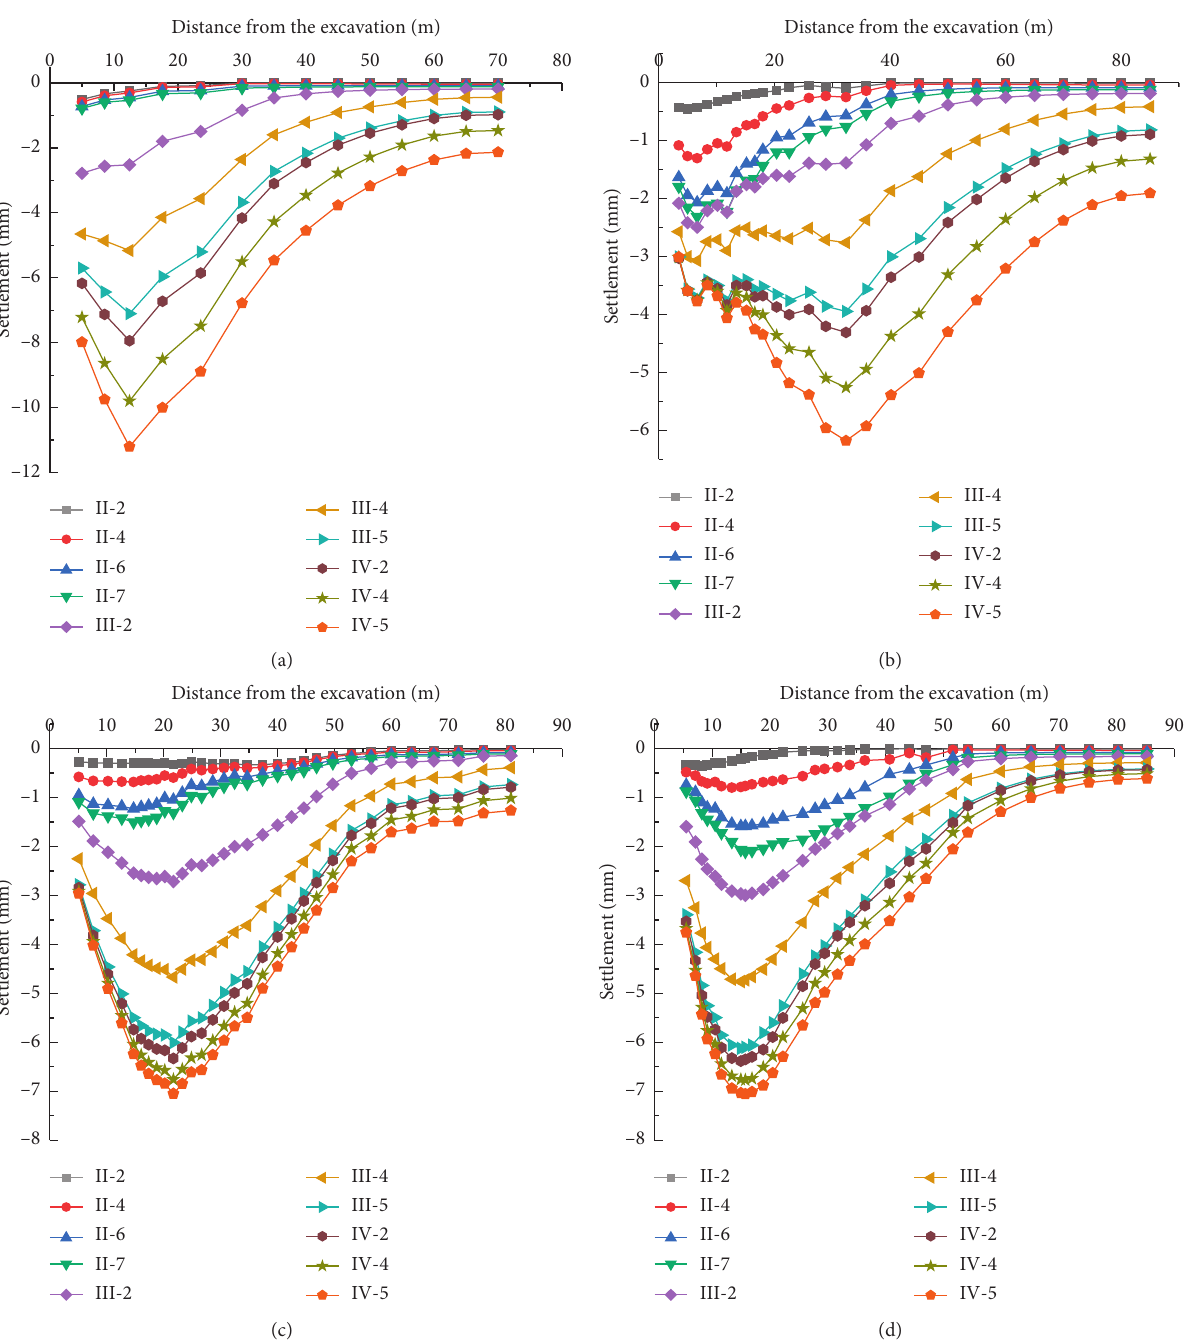
Figure 16: Numerical results of ground surface settlement at S11 (a), S12 (b), S20 (c), and H21